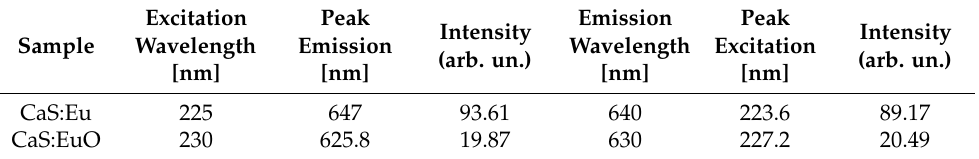
Table 3. Summary of the CaS:Eu and CaS:EuO emission and excitation data acquired from the photoluminescent